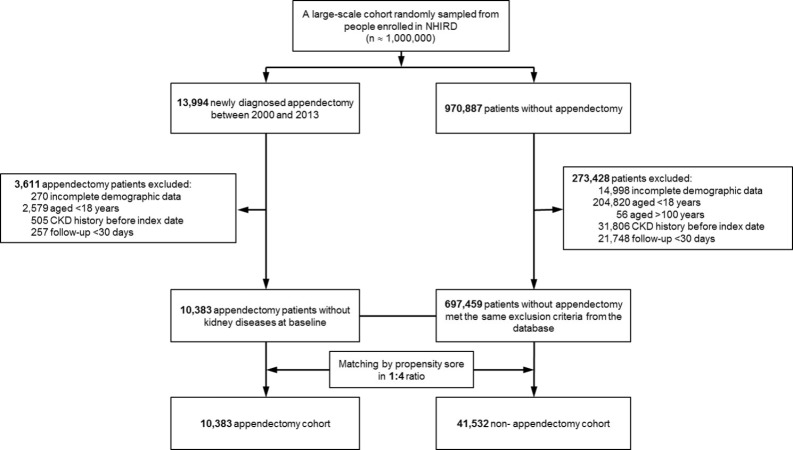
Flowchart.Flowchart of subject selection process.